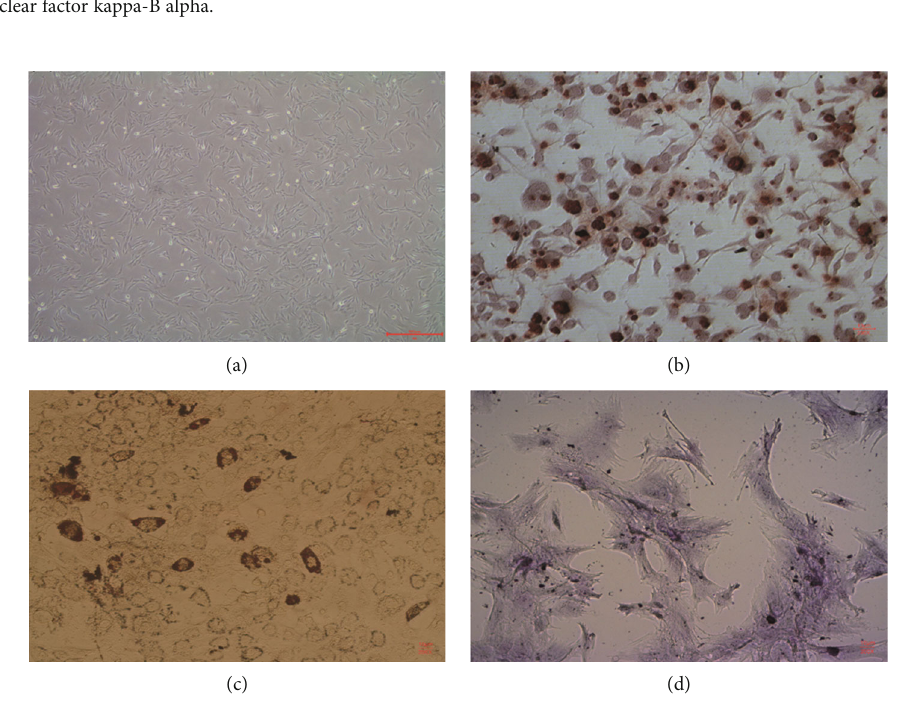
Figure 1: Characterization and multidirectional di ff erentiation potential of stem/progenitor cells from rat gingival tissues. (a) Microscopic appearance of rGMSC morphology (20x). (b) Osteogenic di ff erentiation of rGMSCs after 21 days of osteogenic induction. Positive staining of calci fi ed deposits is observed (200x). (c) Adipogenic di ff erentiation of rGMSCs after 21 days of adipogenic induction. Positive staining of lipid droplets is observed (200x). (d) Chondrogenic di ff erentiation of rGMSCs after 21 days of chondrogenic induction. Positive staining of glycosaminoglycans is observed